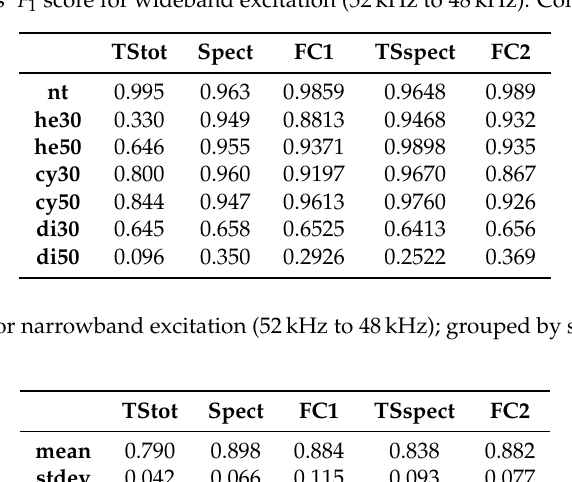
Table A6. Best ANNs’ F 1 score for wideband excitation (52kHz to 48kHz). Compare also Figure 9b.